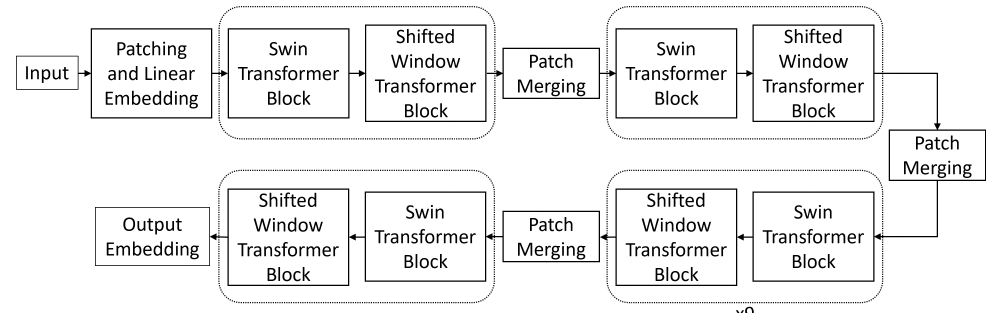
Figure 2. Diagram of the architecture of transformer backbone. Each transformer block has its attention parameters partitioned by windows as shown in Figure